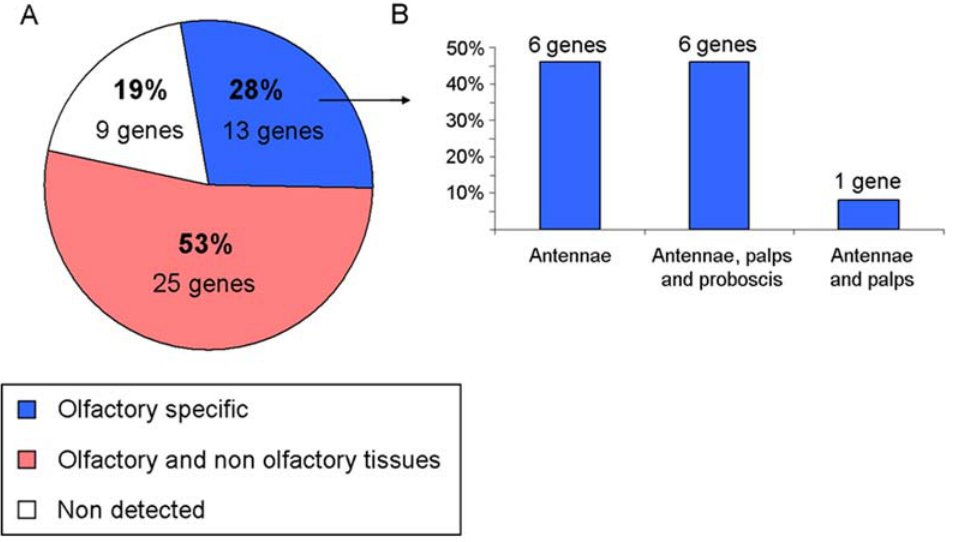
Figure 4. Expression patterns of OBP genes in various tissues of adults Cx.Quinquefasciatus . Specific primers of forty-seven putative OBP genes have been used in non quantitative RT-PCR experiments using thirty-four cycles of amplification. (A) OBP genes can be subdivided into three main categories. Olfactory-specific genes were detected exclusively in antennae, maxillary palps or proboscis. (B) Distribution profiles of olfactory- specific genes in olfactory tissues. Details are available in Table